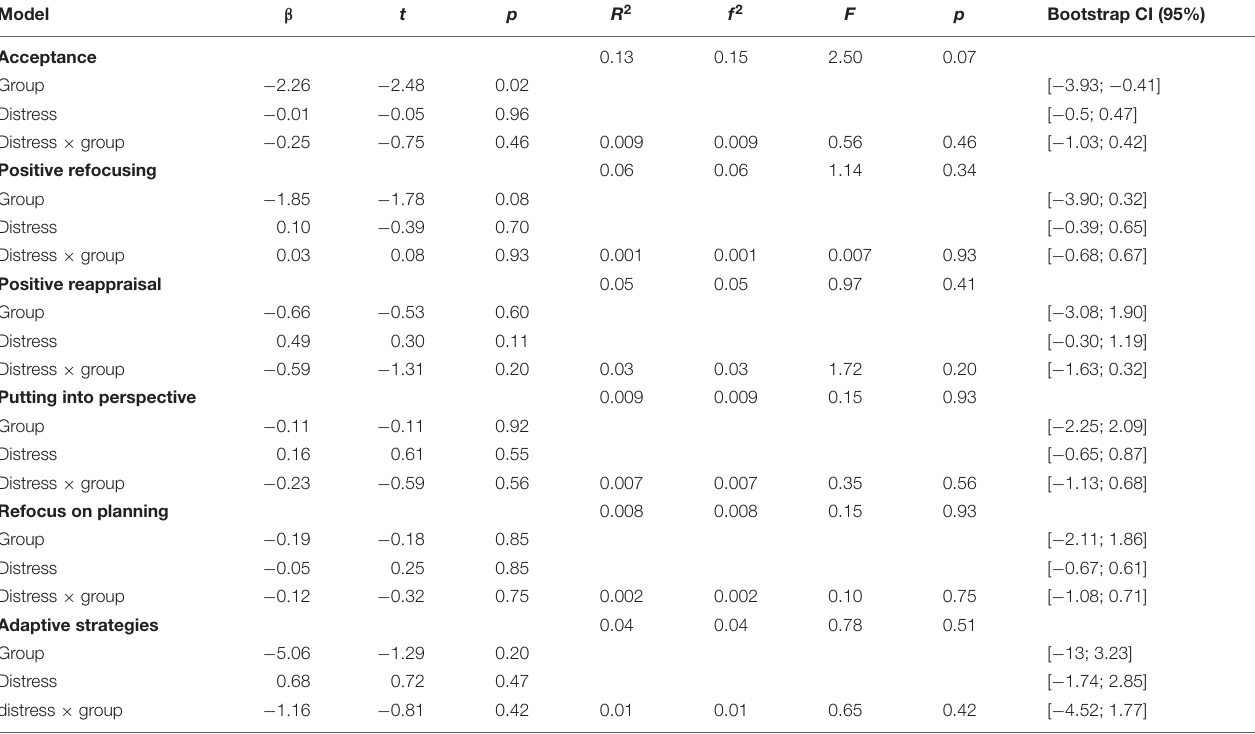
TABLE 2 | Multiple regression analyses predicting adaptive emotion regulation strategies as a function of group (BD and C), distress and their interaction.